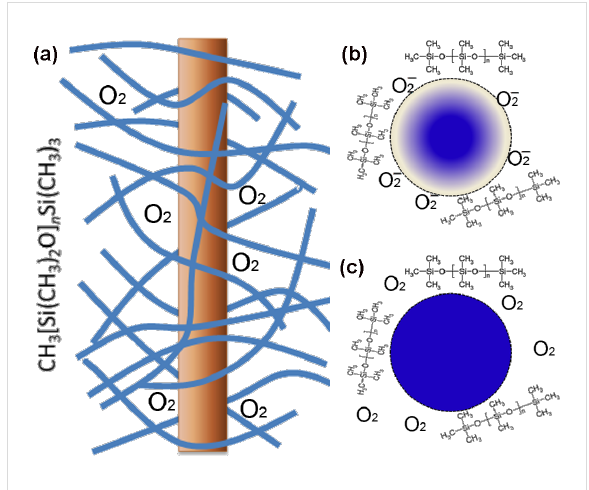
Figure 5: (a) Illustration of a ZnO nanowire in cross-linked PDMS. The blue lines represent PDMS molecule chains; (b) Illustration of a nanowire in PDMS without UV illumination, with oxygen adsorbed on parts of the surface. The colour gradient across the cross-section indi- cates a depletion layer near the surface; (c) Under UV illumination the oxygen molecules desorb from ZnO and diffuse into the molecule